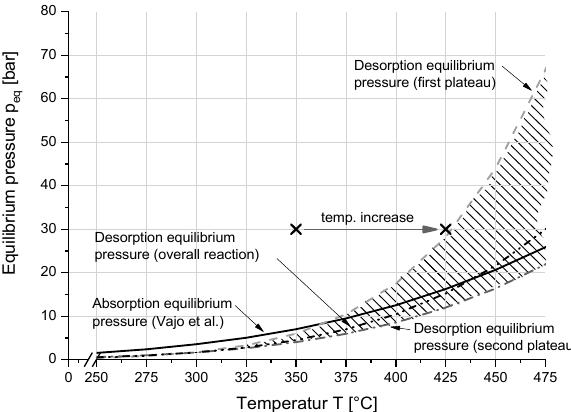
Figure 11. Equilibrium pressure for the two plateaus of the desorption reaction of the Li-RHC system estimated with the PCI measurements in desorption conditions as well as overall reaction of both and the curve determined by Vajo et al. [34] in absorption conditions.